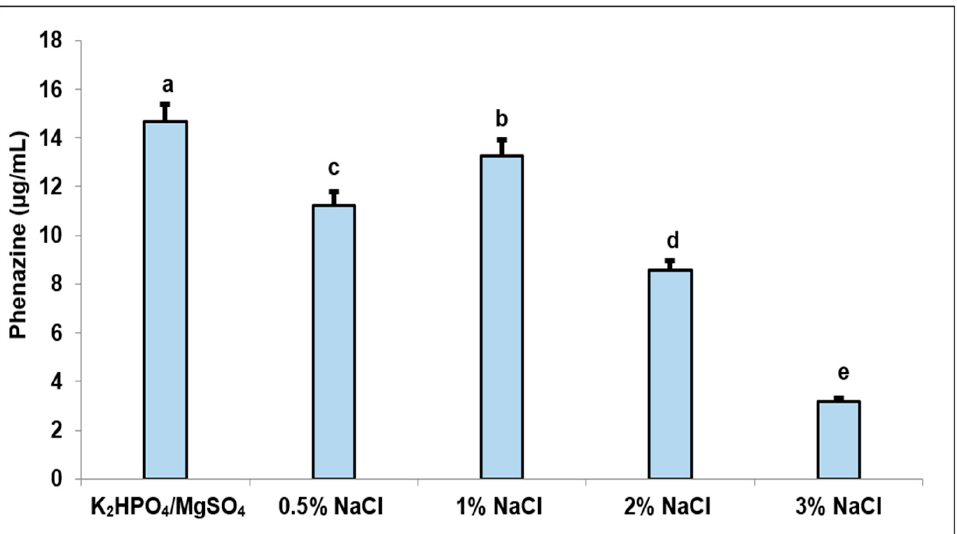
Figure 2. The effect on phenazine production of K 2 HPO 4 and MgSO 4 system (control) compared to NaCl at concentrations including 0.5, 1, 2, 3%. Values with the different letters are significantly different. LSD value of 0.115 ; CV value of 0.412766.